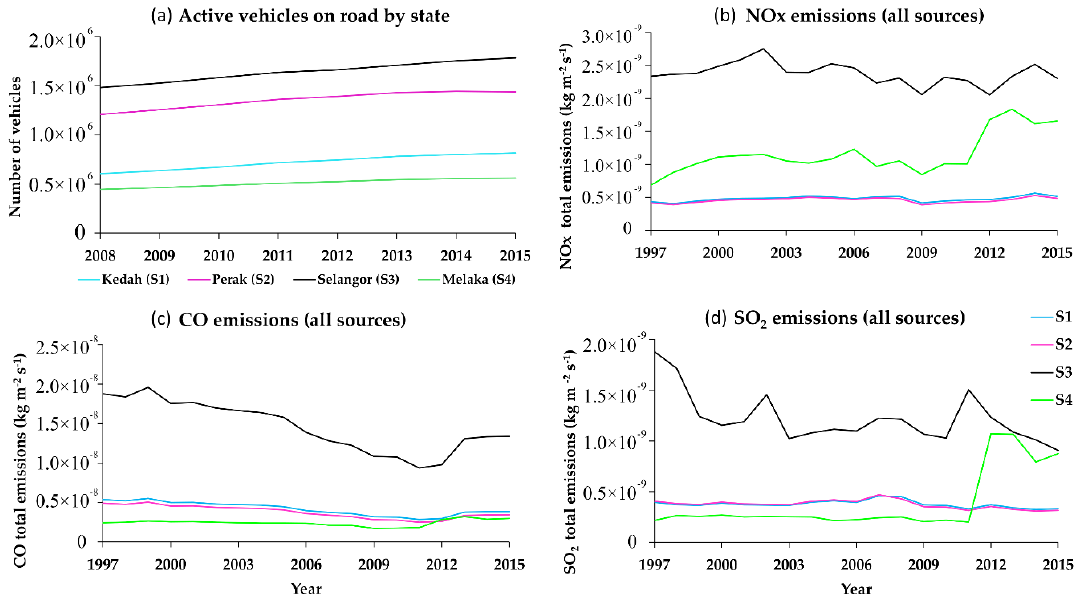
Figure 5. Time series of total active vehicle count by state for the period 2008–2015 ( a ) and total emissions (all sources) for NOx, CO and SO2 for the period 1997–2015 ( a – c ).